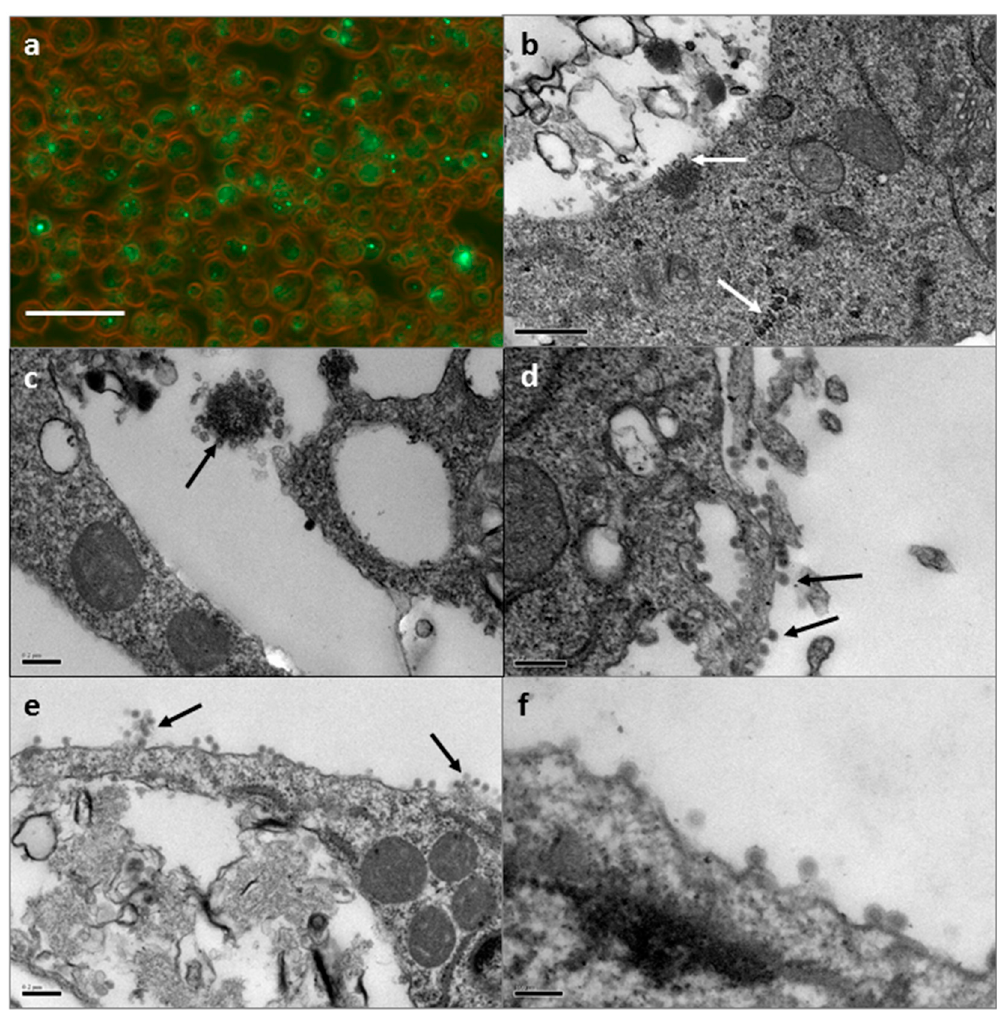
Figure 1. SFV in the tick cell line BDE/CTVM16. ( a ) Light micrograph of SFV-infected tick cells at 48 hpi; foci of green fluorescence correspond to location of viral replication complexes. Scale bar 50 µ m; combined brightfield and ultra-violet (UV) illumination; ( b – f ) Electron micrographs of SFV-infected tick cells at 24 hpi; ( b ) Array of intracellular spherules resembling those associated with CPV-I (arrows); scale bar 0.5 µ m; ( c ) Cluster of intracellular spherules (arrow); scale bar 0.2 µ m; ( d , e ) Virus particles (arrows) at the surface of the cell membrane; scale bar 0.2 µ m; ( f ) Higher magnification view of virus particles at the cell surface; scale bar 0.1 µm.